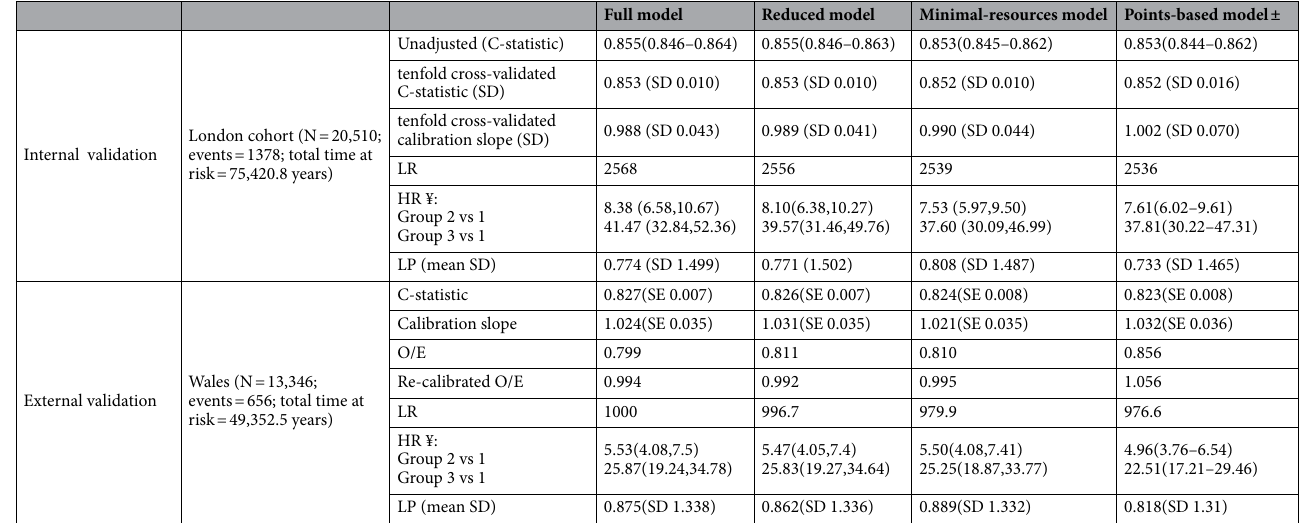
Table 3. Validation statistics for 5-year predicted risk of incident stage 3 CKD. LR likelihood-ratio test statistic; HR Hazard ratio; LP linear-predictor; O / E observed risk/estimated risk. Models were internally validated using tenfold cross validation. ¥ Group 1, 2 and 3 indicate participants grouped into the low- moderate, high and very high-risk groups, respectively. ± For the points-based model categories were determined based on cox’s cut points from the minimal resources model. Moreover, the total score (adapted from coefficients of model 3) was fitted as a predictor on its own in a cox regression model for the validation, the reported statistics can be interpreted as measurements of